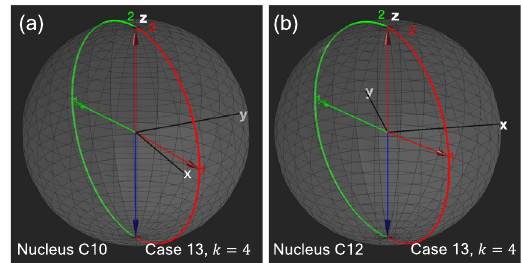
FIG. 19. Evolution of nuclear spins C10 (a) and C12 (b) up to the decoding, if no error occurs on the electron during the CR QEC protocol. Initially, both nuclei are in the j 1 i state (blue arrow). If the electron starts in the j 0 i ( j 1 i ) state, the nuclear spins follow the green (red) trajectory. The final state of each spin is indicated with the red arrow pointing to the North pole of the Bloch sphere (the final green and red arrows coincide).